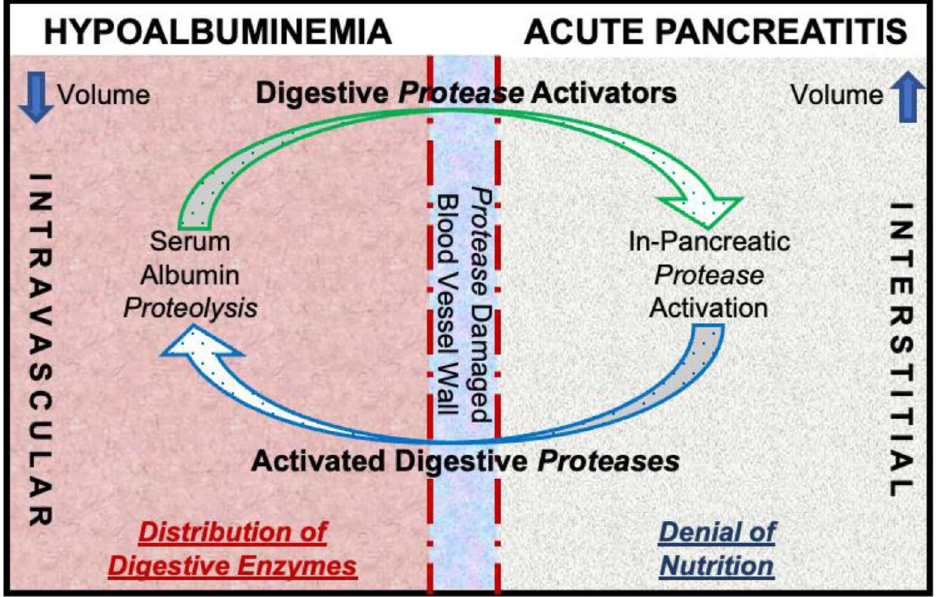
Figure 3. When hypoalbuminemia and acute pancreatitis coexist, a degradation cycle comes into play. Intravascular proteases digest serum albumin and induce blood vessel leakage. Serum-origin proteases migrate into the interstitial space. Trypsin, in particular, serves as activator of pancreas-origin proteases, lipases and amylases. In-pancreatic activation of digestive enzymes damages pancreatic tissues and attacks vasculature from the interstitial space, allowing passage of even more destructive proteases into the serum. Systemic impacts include distribution of digestive enzymes throughout the vascular system and denial of